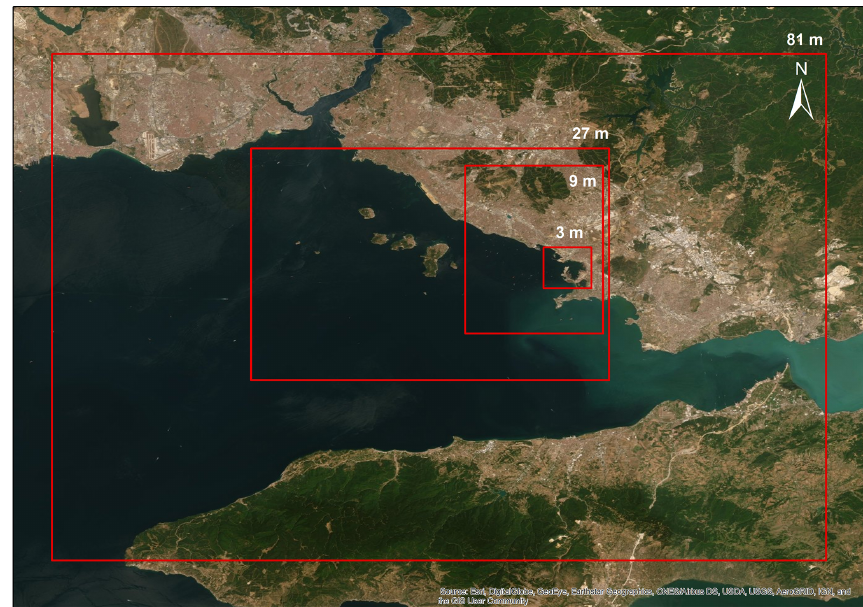
Figure 4. Nested domains for tsunami numerical modeling. Red rectangles show the limits of these domains. Grid size of these domains have a certain 1 : 3 ratio between each other (created using ArcMap version